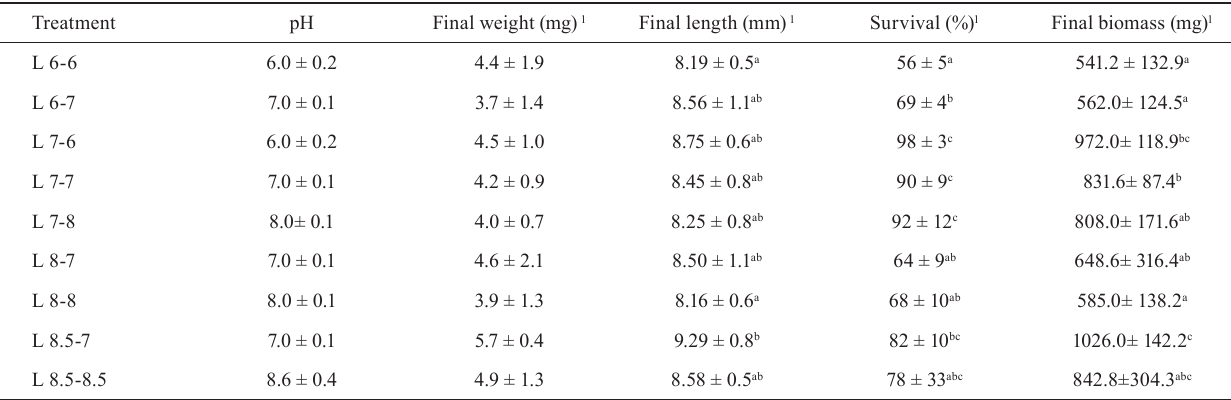
Table 3. Average values ± standard deviation of water pH, weight, length, biomass, and survival at the end of 16 days of larviculture for Prochilodus lineatus in the different treatments. 1 Different letters in the same column indicate statistical differences in the averages for the Tukey test (P <